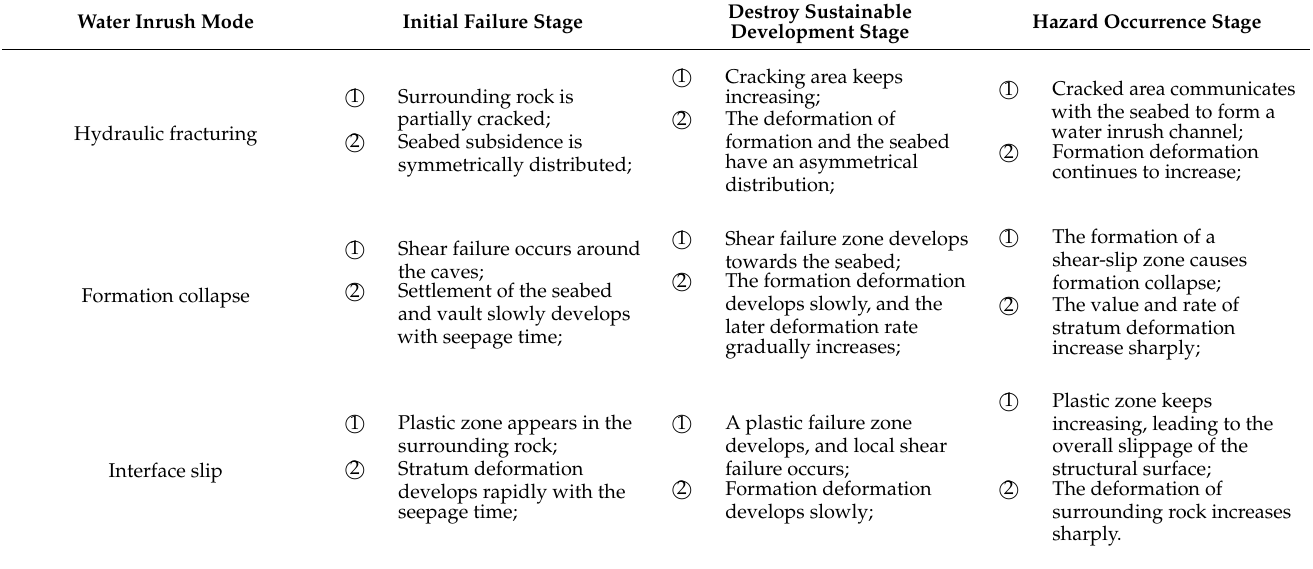
Table 6. Characteristics of water inrush failure stages of different water inrush